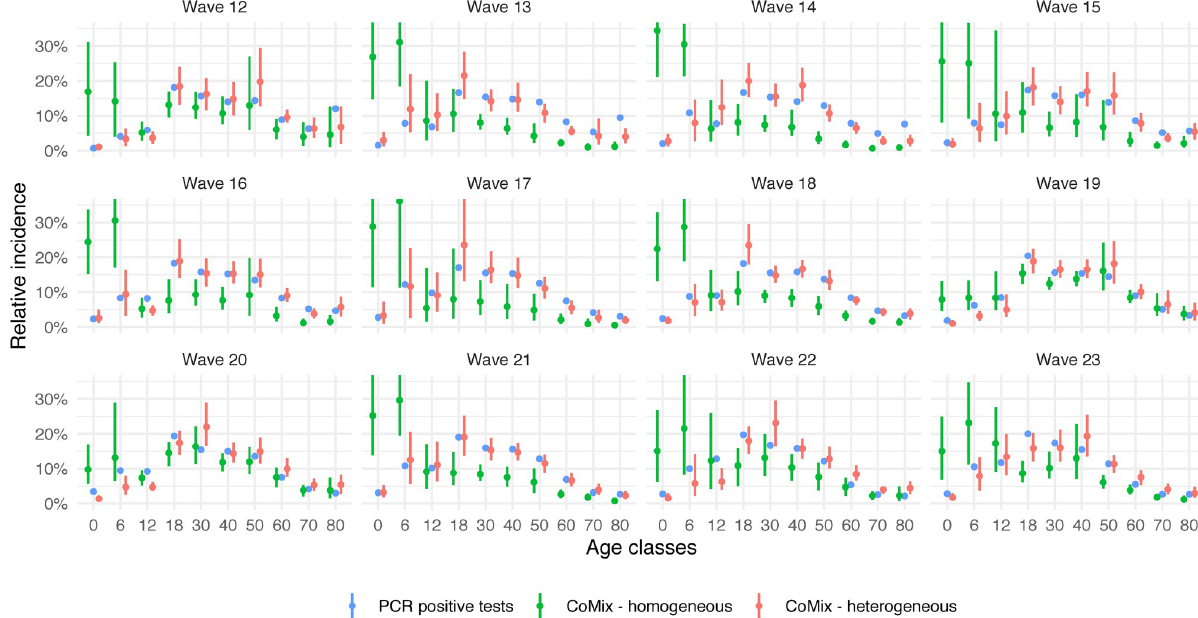
Fig 2. Estimated relative incidence. In blue: relative incidence based on Belgian PCR data. In green: estimated relative incidence based on the next generation principle under the assumption of a homogeneous proportionality factor. In red: estimated relative incidence based on the next generation principle with an estimated age-specific q -susceptibility under the assumption on age-specific infectiousness as in Fig 1. Dots represent means and bars represent 95% percentile (nonparametric) bootstrap-based confidence intervals.